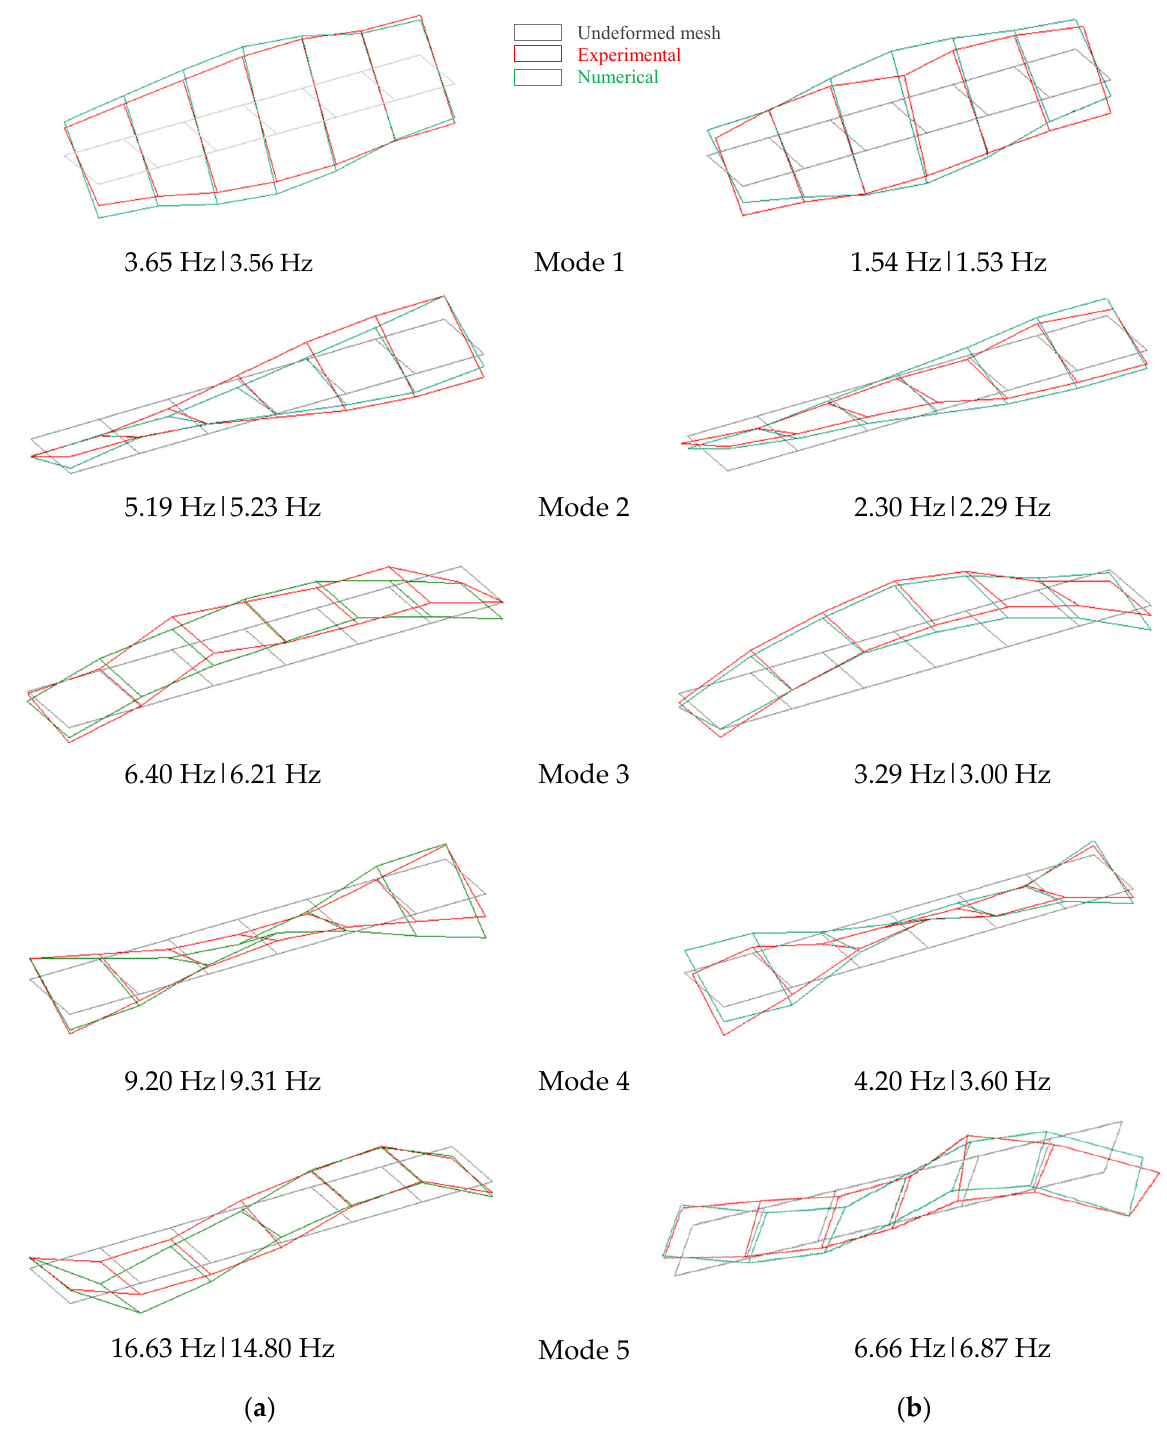
Figure 20. Comparison between the experimental and numerical modal configurations after updating modal parameters: ( a ) unloaded configuration, ( b ) loaded configuration.